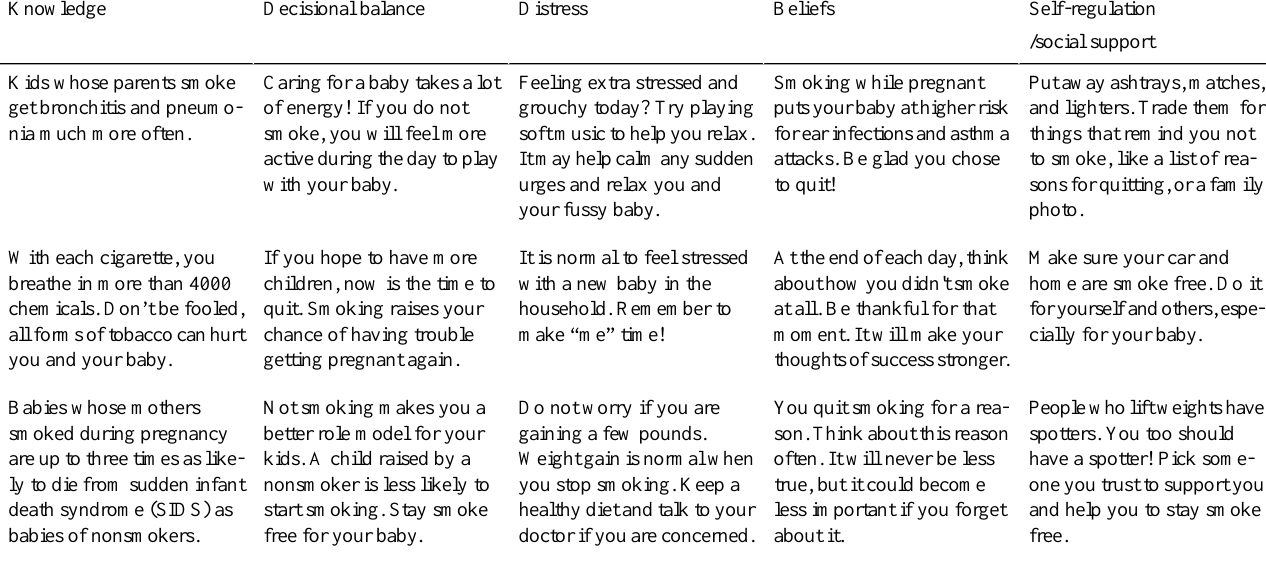
Table 3. Samples of final text messages across 5 C-SHIP constructs.